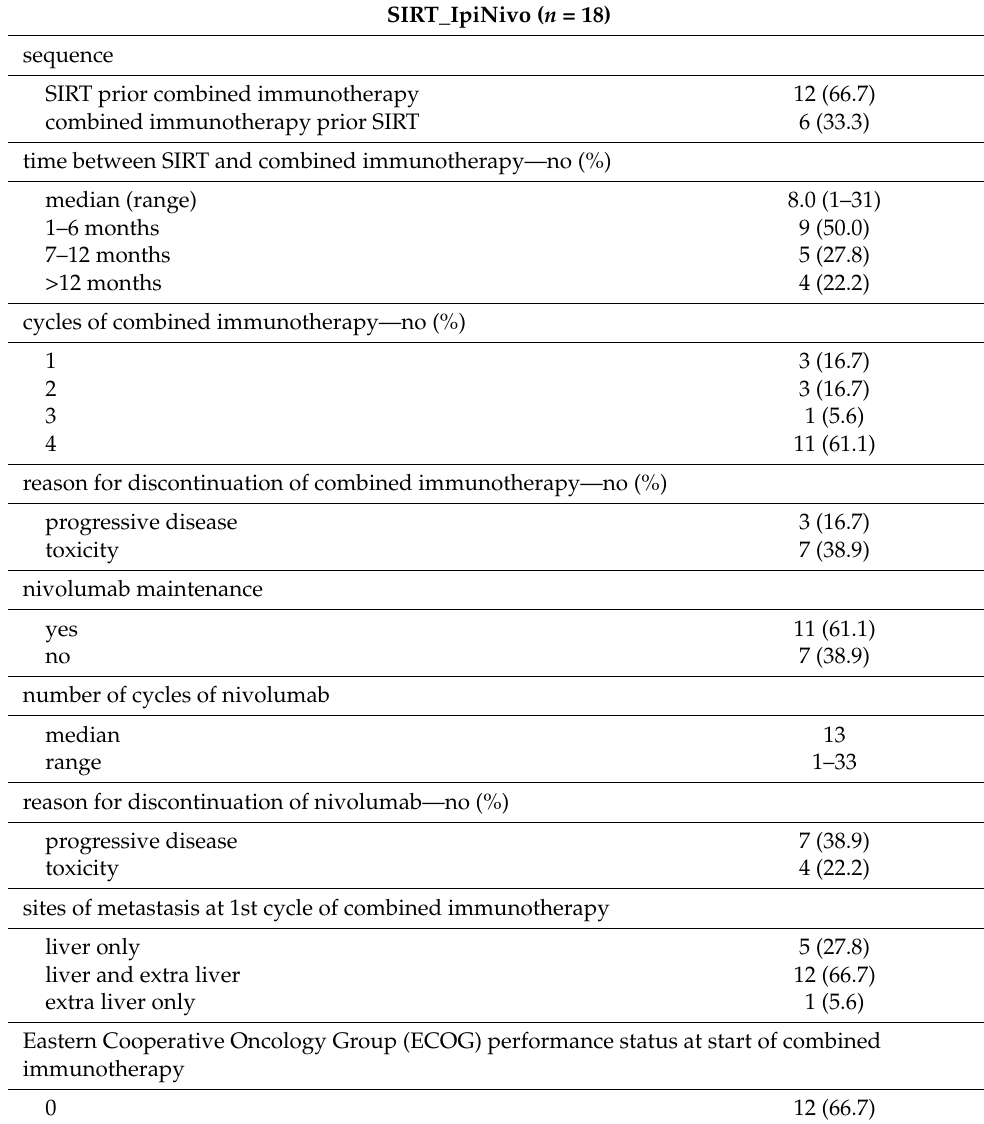
Table 2. Characteristics of treatment and responses to ipilimumab and nivolumab